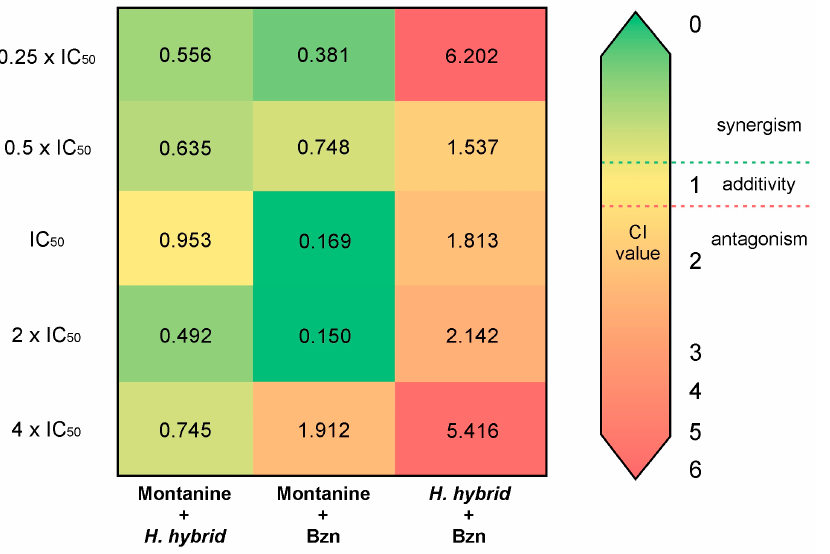
Figure 4. Synergy heat map compiling CI values. The squares in the figure indicate antagonism (CI > 1.2, orange-red), additivity (0.9 < CI < 1.1, yellow), and synergism (CI < 0.9, green) among montanine, H. hybrid BARE, and Bzn against T. cruzi epimastigotes.